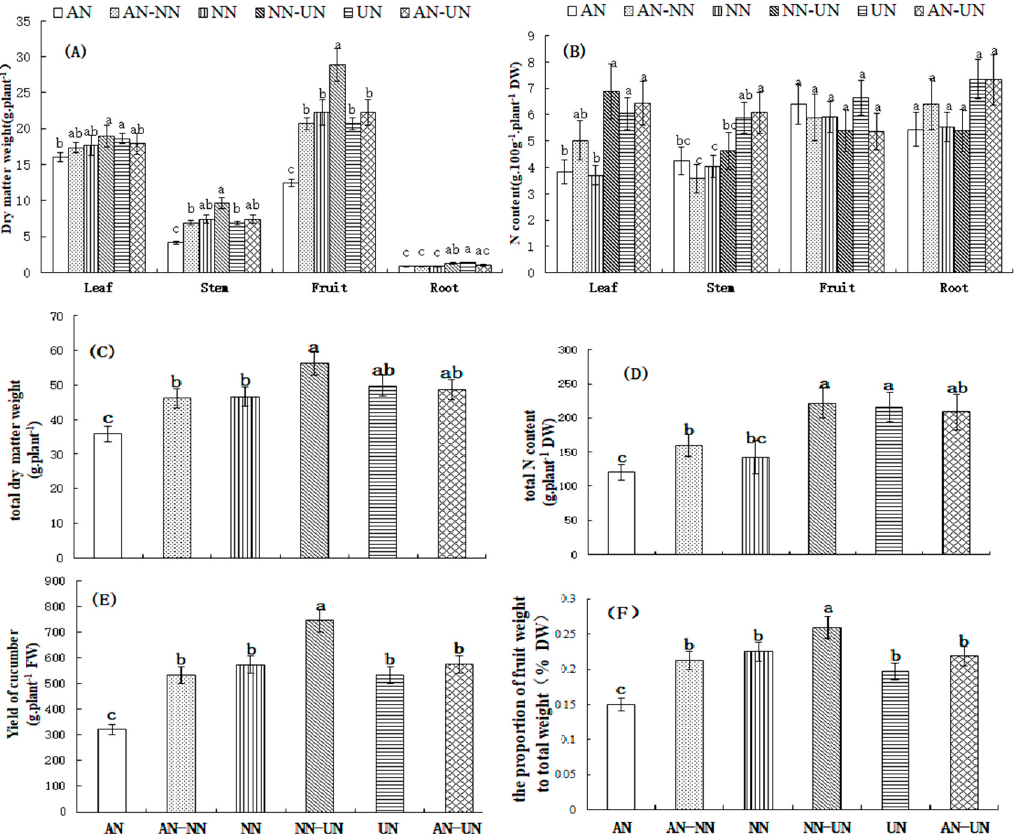
Figure 1. E ff ect of di ff erent nitrogen forms on dry matter weight, nitrogen content, and yield in Figure 1 Effect of different nitrogen forms on dry matter weight, nitrogen content, and yield in cucumber. ( A ) Dry matter weight of each individual organ; ( B ) Nitrogen content of each individual cucumber. A . Dry matter weight of each individual organ; B . Nitrogen content of each individual organ; ( C ) Dry matter weight of each individual plant; ( D ) Nitrogen content of each individual plant; organ; C . Dry matter weight of each individual plant; D . Nitrogen content of each individual plant; ( E ) Yield of each individual plant; ( F ) E ff ect on root–shoot ratio of the nitrogen form. Bars represent the E . Yield of each individual plant; F . Effect on root–shoot ratio of the nitrogen form. Bars represent the standard error. Di ff erent letters above the bars indicate significant di ff erences at p < 0.05 according to standard error. Different letters above the bars indicate significant differences at p < 0.05 according to Tukey’s multiple comparison Tukey’s multiple comparison test.